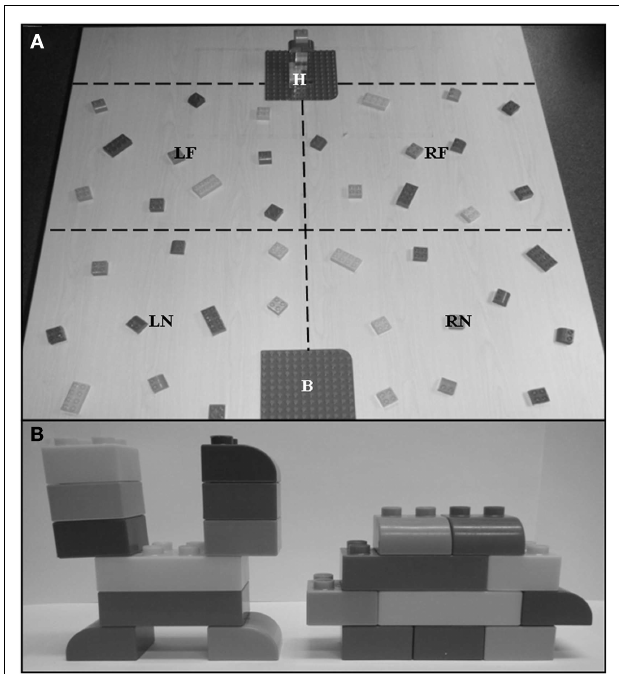
FIGURE 1 | Experimental set-up . (A) Example of workspace prior to first trial. Red dashed lines notionally divide the workspace into quadrants; left near (LN), left far (LF), right near (RN), and right far (RF) reachable space. Model to be replicated is located on far base plate “H” positioned between LF and RF quadrants. Model to be constructed on near base plate “B” positioned between LN and RN quadrants. (B) Examples of 10-piece models.Workspace set-up and models are illustrated with MEGA